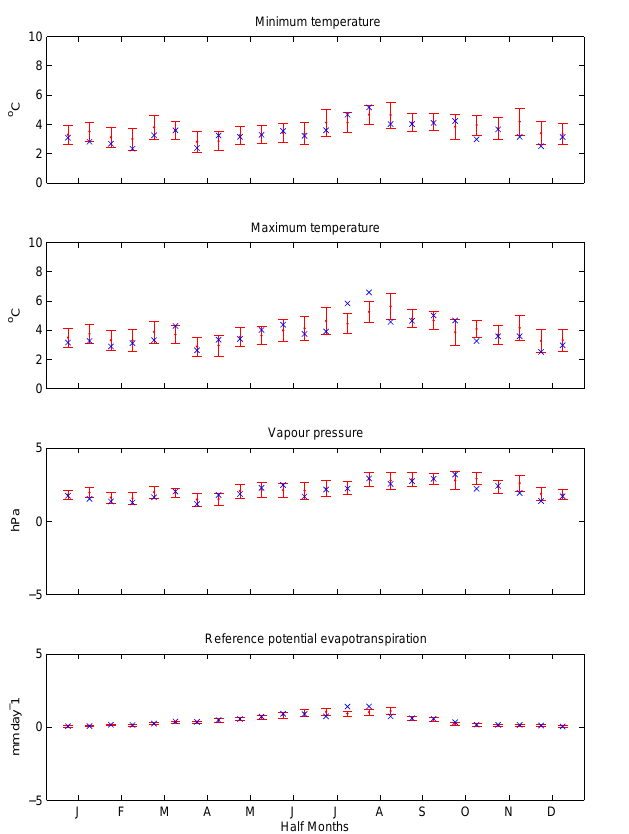
Fig. 3d. RCM 2080s scenario (HadRM3Q0 – blue, shown as crosses) and simulated (red dots and error bars) changes for each half month for the grid cell nearest Heathrow based on a 30yr pe- riod (1961–1990) showing the changes with respect to the RCM control period (Fig. 3b). The simulated values are the means of 100 weather generator runs. The lines and bars show the variability of the changes for the 100 runs (plotted as plus/minus two standard deviations around the mean).